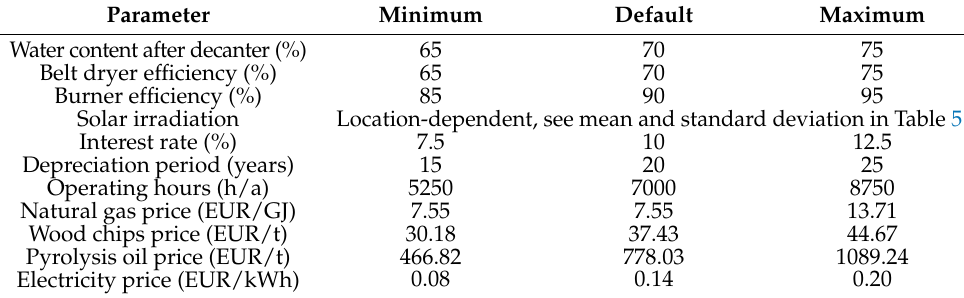
Table 6. Parameter ranges for Monte Carlo simulation.